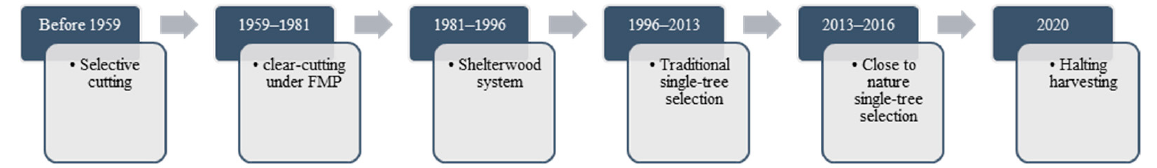
Figure 1. The timeline for various silvicultural methods in the Hyrcanian forests, based on [41].